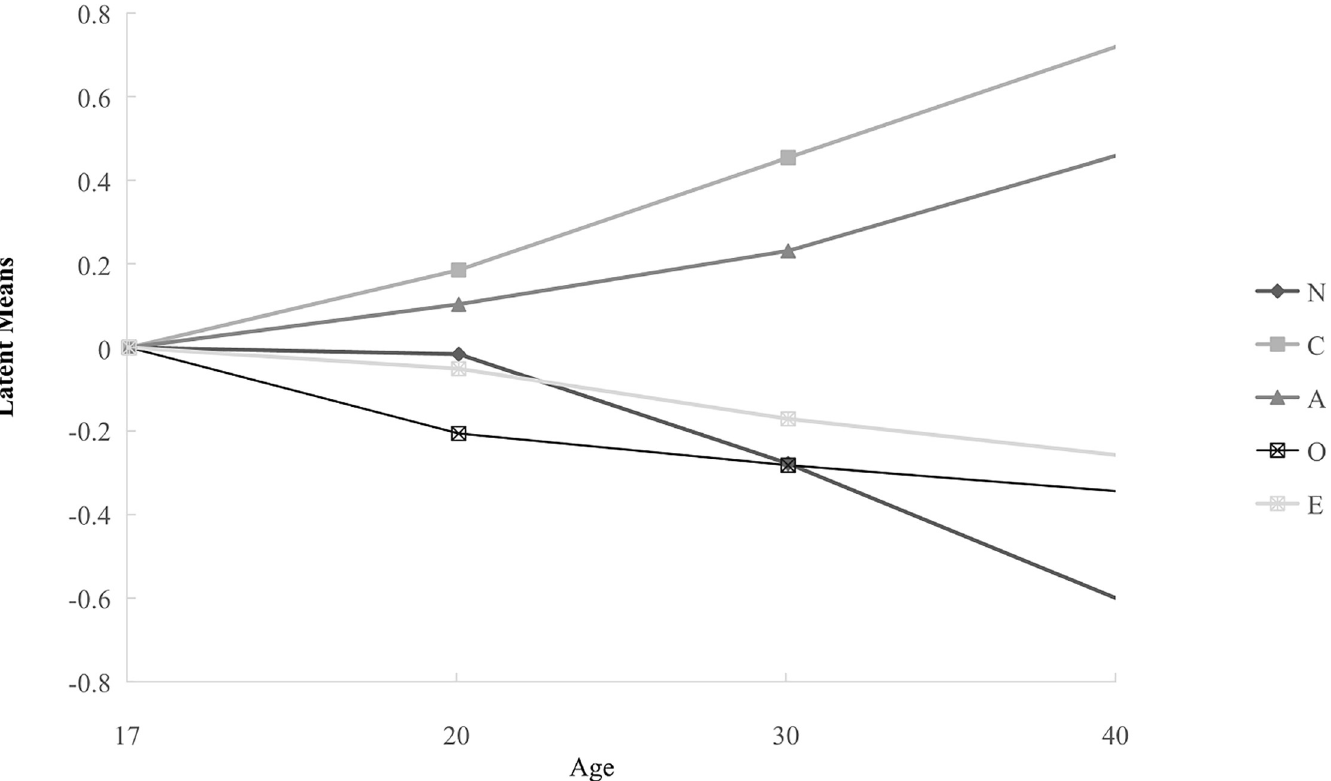
Fig 1. Latent means of Big Five dimensions results across different age